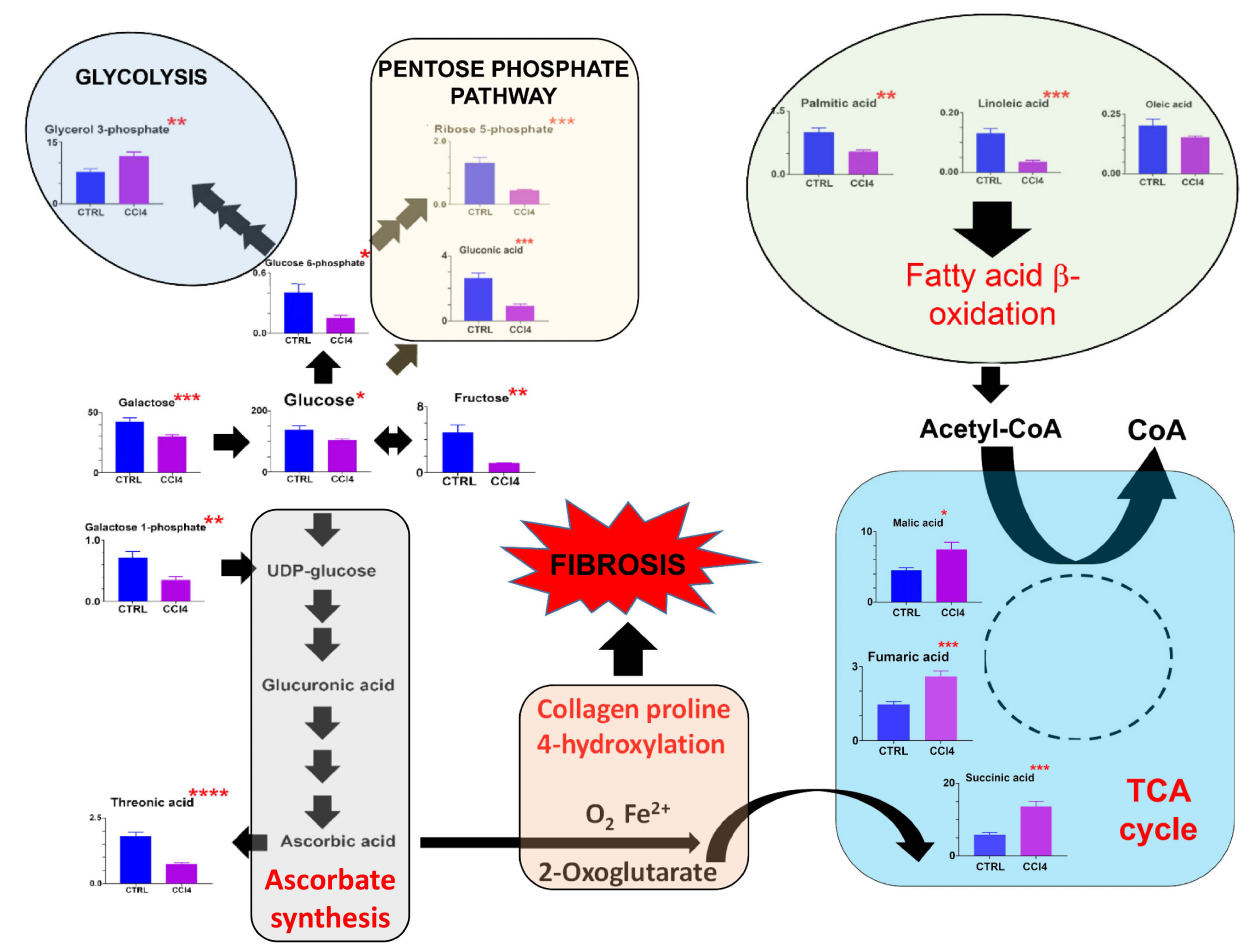
Figure 3. The appropriation of glucose metabolism for ascorbate synthesis in the livers of mice administered carbon tetrachloride * = p < 0.05; ** = p < 0.01; *** = p < 0.001; **** = p <